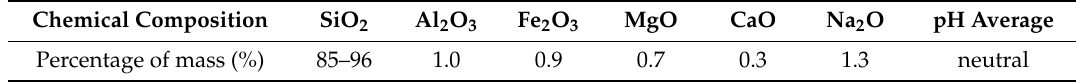
Table 3. Chemical composition of silica